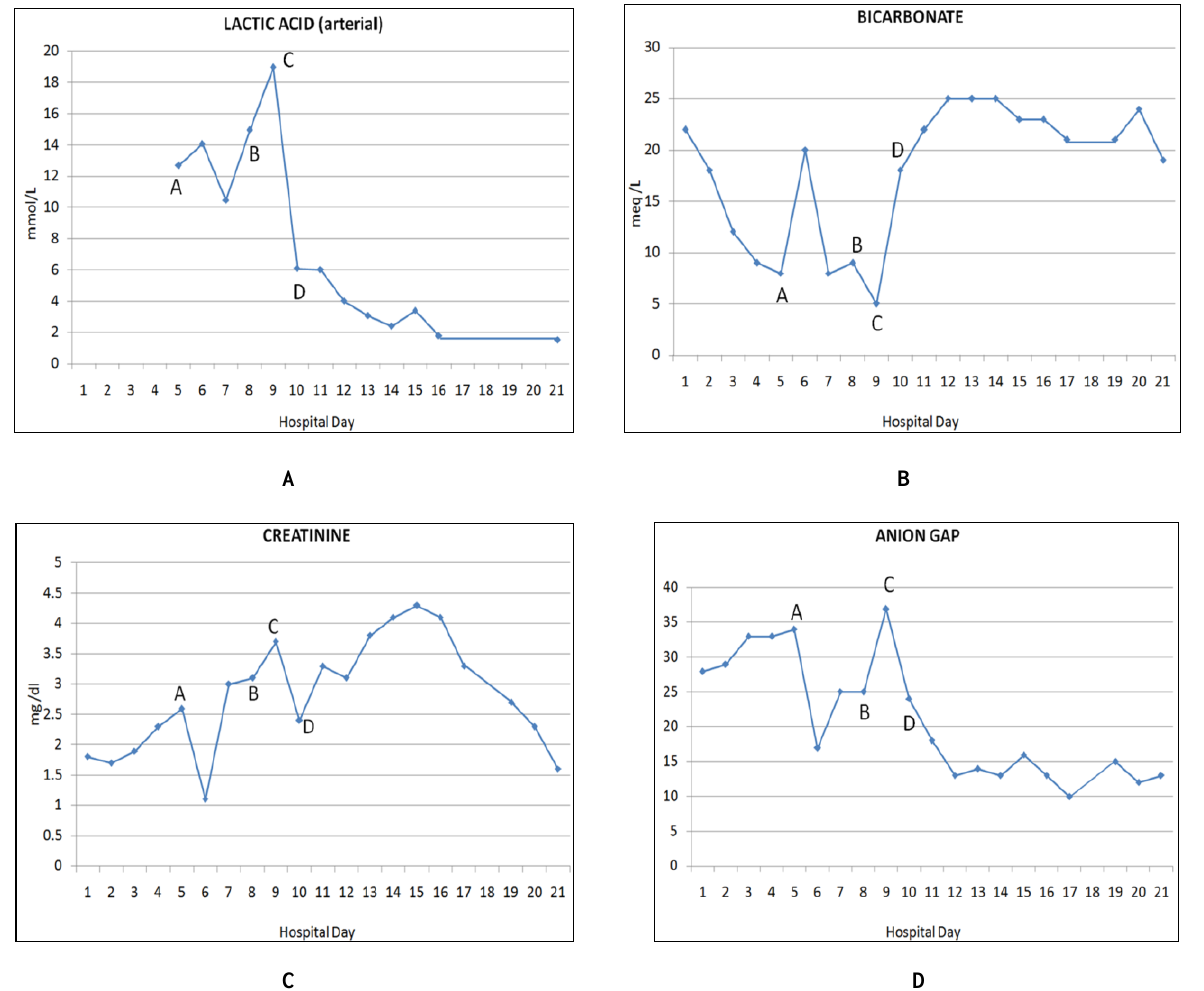
FIGURE 1. Variation of lactic acid (A), bicarbonate (B), creatinine (C), and anion gap (D) before the patient became septic. A: transient hypotension, development of acute renal failure, hemodialysis started; B: thiamine and prednisone started; C: bicarbonate drip started; D: hemodialysis and bicarbonate drip